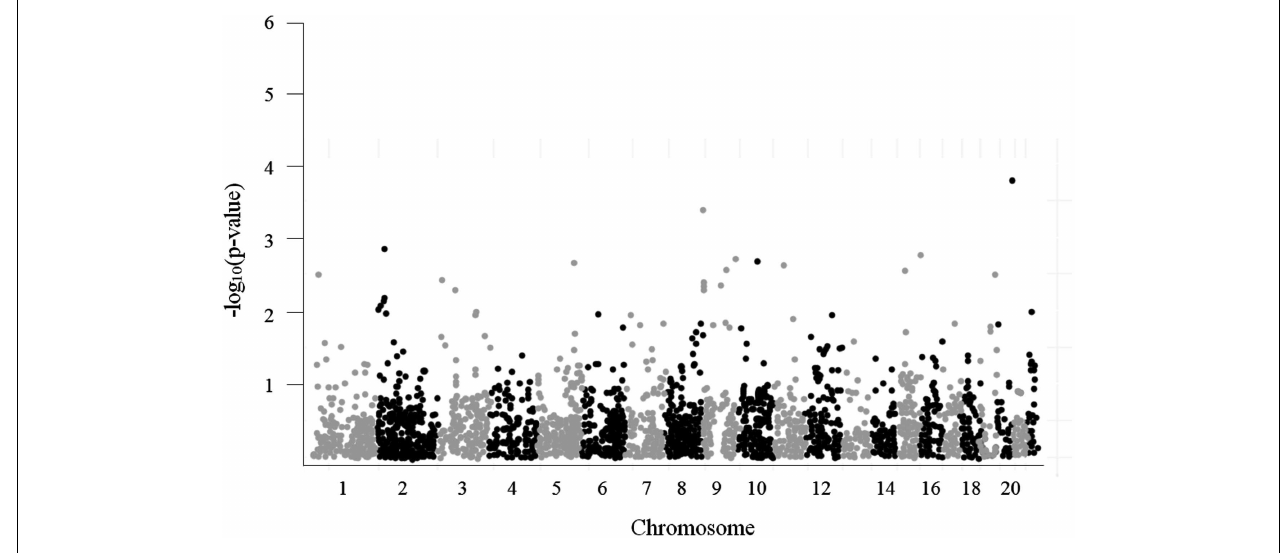
FIGURE 4 | Manhattan plot for 3,961 tested candidate